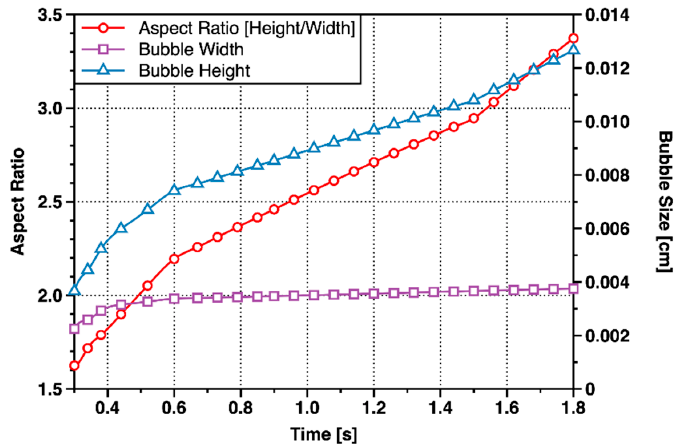
Figure 8. Changes in shape of the minor bubble with time.